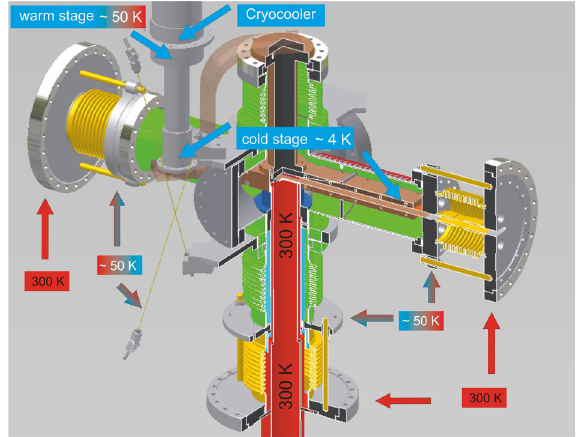
FIG. 4. Highlighted in yellow are the transition from 300 to 50 K, and in green the transitions from 50 to